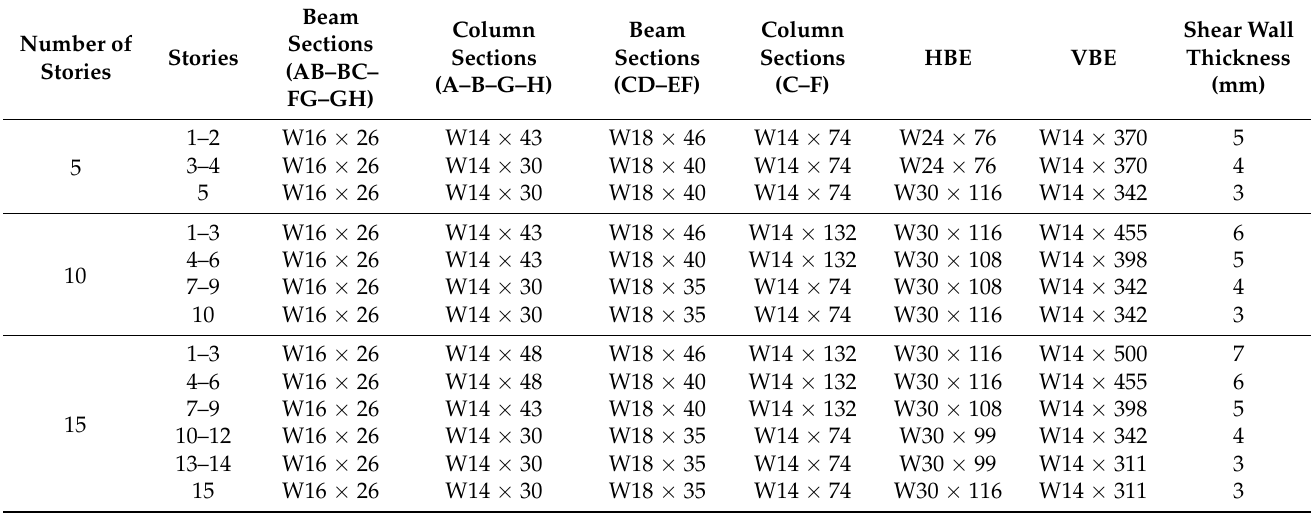
Table 1. Beam, column and steel plate sections at different stories.